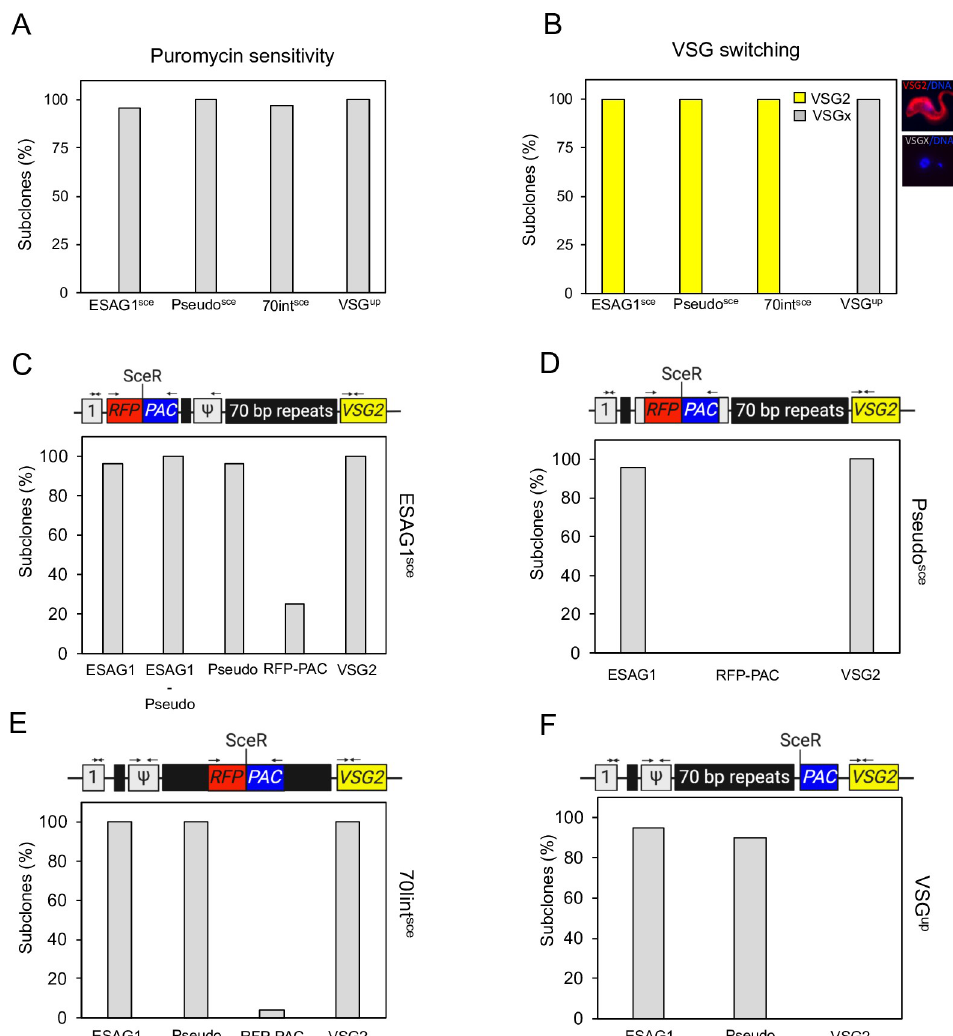
details of the primer sites. grey box ‘1’, ESAG1; grey box C , pseudo gene; black boxes, 70 bp repeats; yellow box,